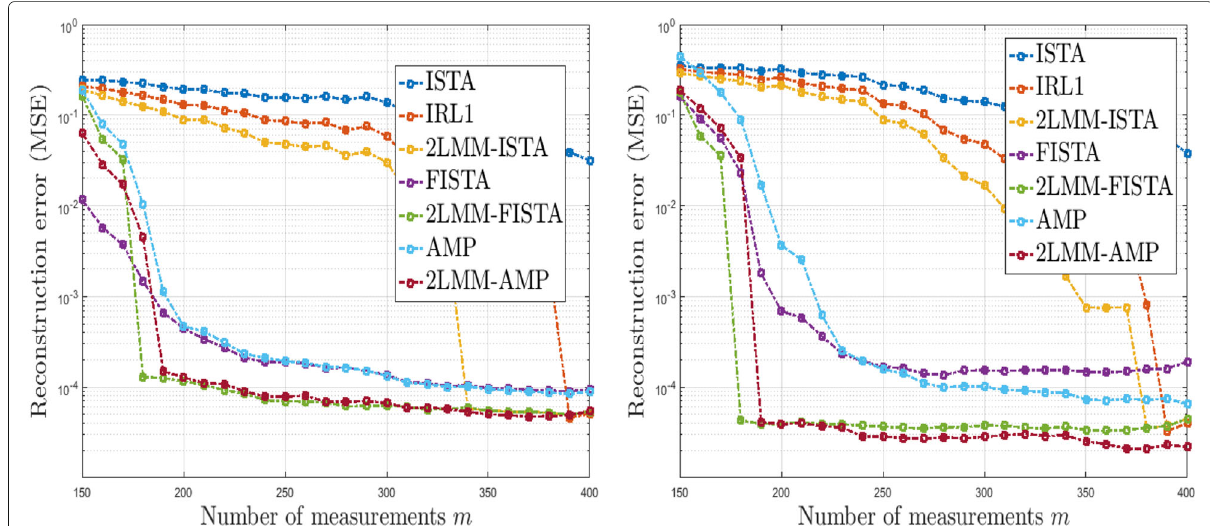
Fig. 10 Analysis of performance in imperfect scenarios: MSE versus number of measurements for recovery of not exactly sparse signals (left) and of exactly sparse signals in presence of noise (right), n = 512, k = 56